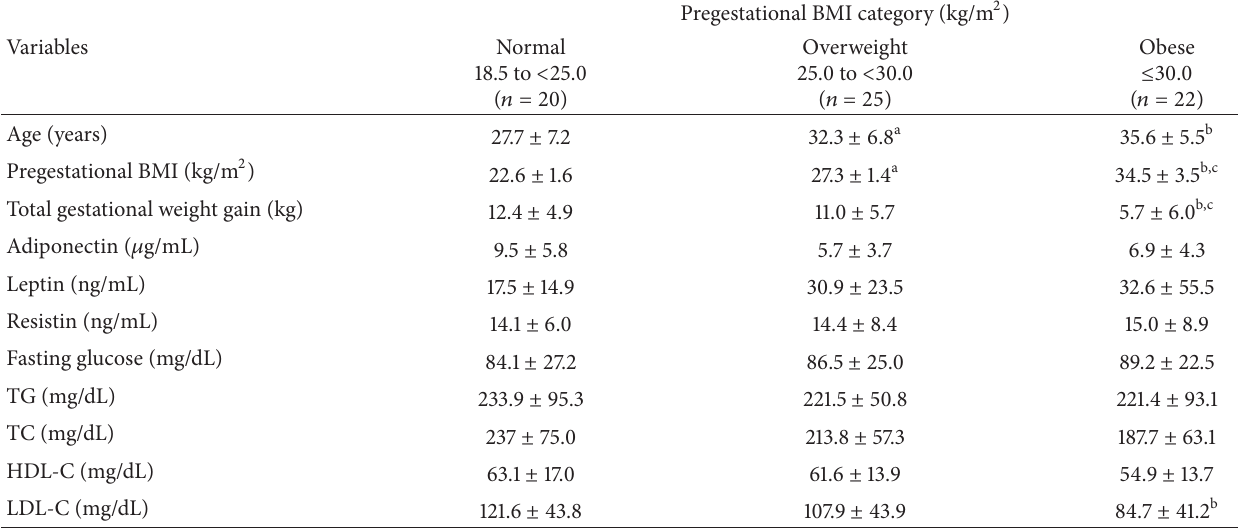
Table 1: Maternal anthropometric and biochemical measurements according to the pregestational BMI category.